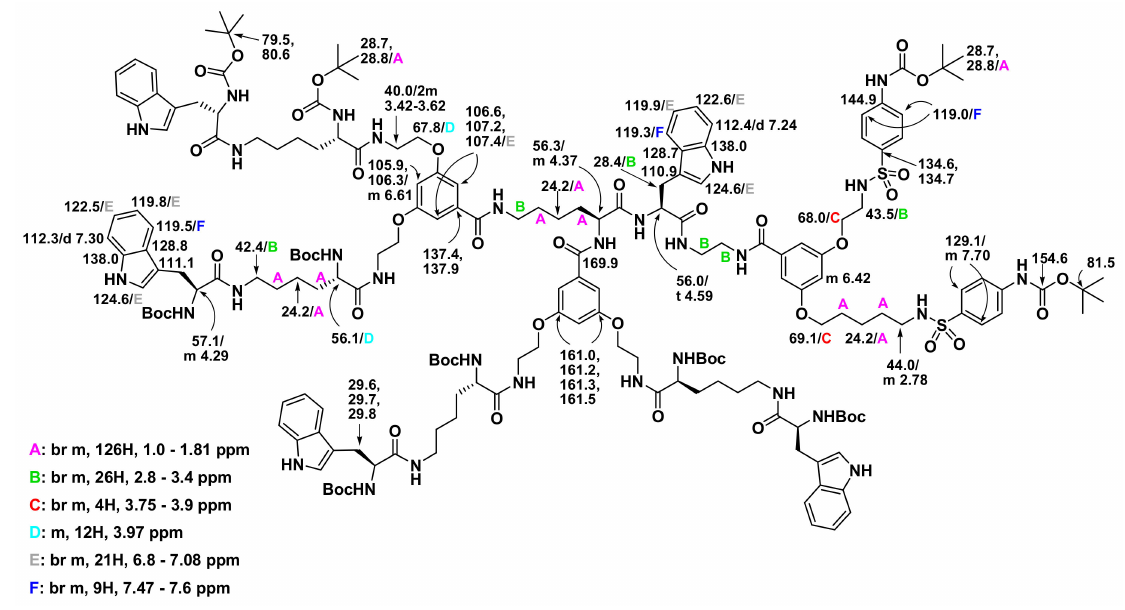
Figure 1. 1 H NMR and 13 C NMR chemical shifts assignment for the Boc-protected bola dendrimer 25